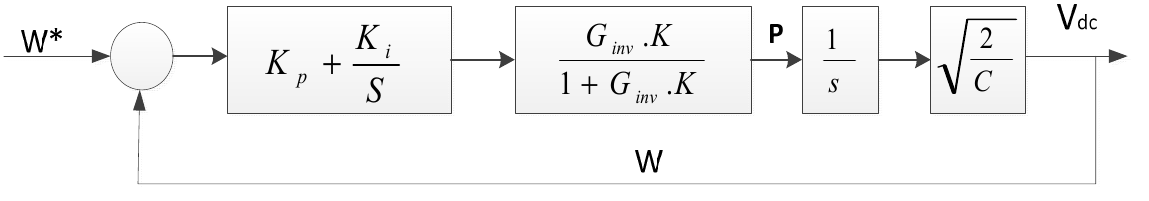
Figure 11. The control loop for the DC link.